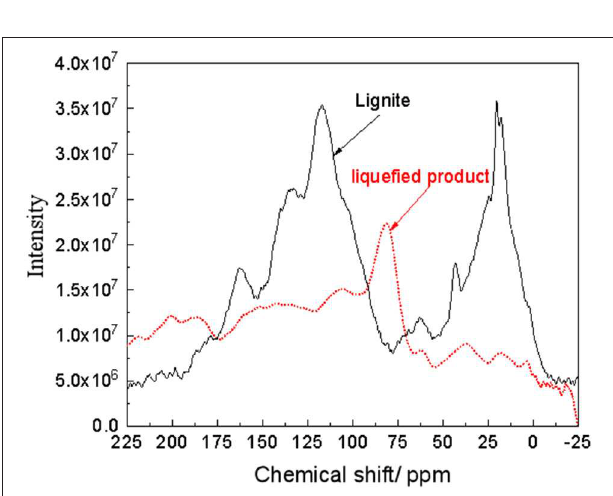
FIGURE 7 | 13 C NMR spectra of coal and liquefaction